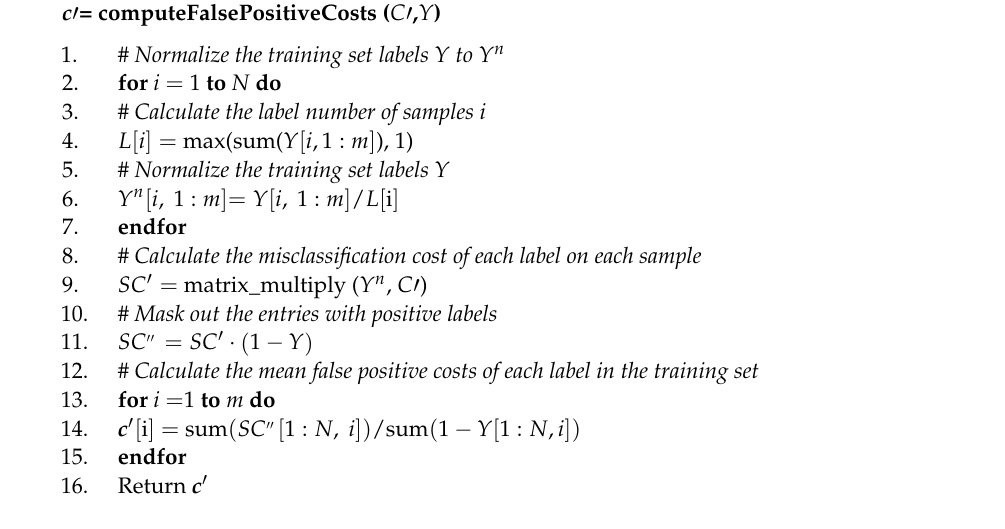
Algorithm 1 The pseudo-code of the algorithm to convert the cost matrix to multi-label classification cost. C (cid:48) denotes the cost matrix specifying the misclassification cost between each pair of categories. Y is the label matrix of the training dataset. c (cid:48) contains the derived